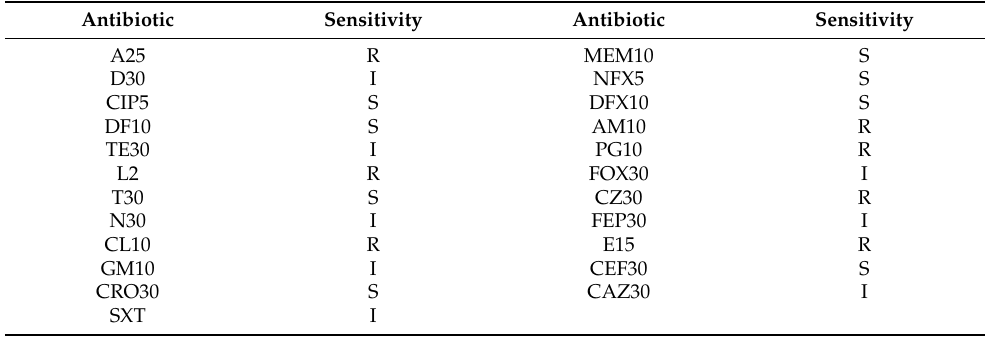
Table 2. Antibiogram result of M. morganii isolates from Hirudo medicinalis